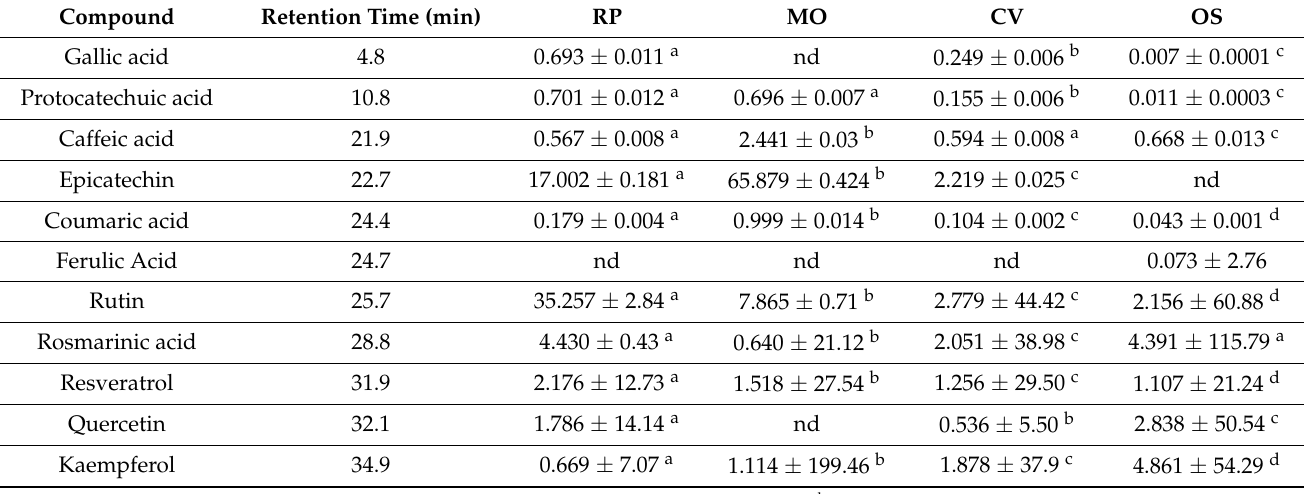
The values are expressed as mean values ± standard deviations of all measurements. a–d t-test was used to compare the means differences registered among samples; data within the same row sharing different superscripts are significantly different ( p < 0.05); data within the same row sharing the same superscripts are not significantly different ( p > 0.05); nd— not detected .